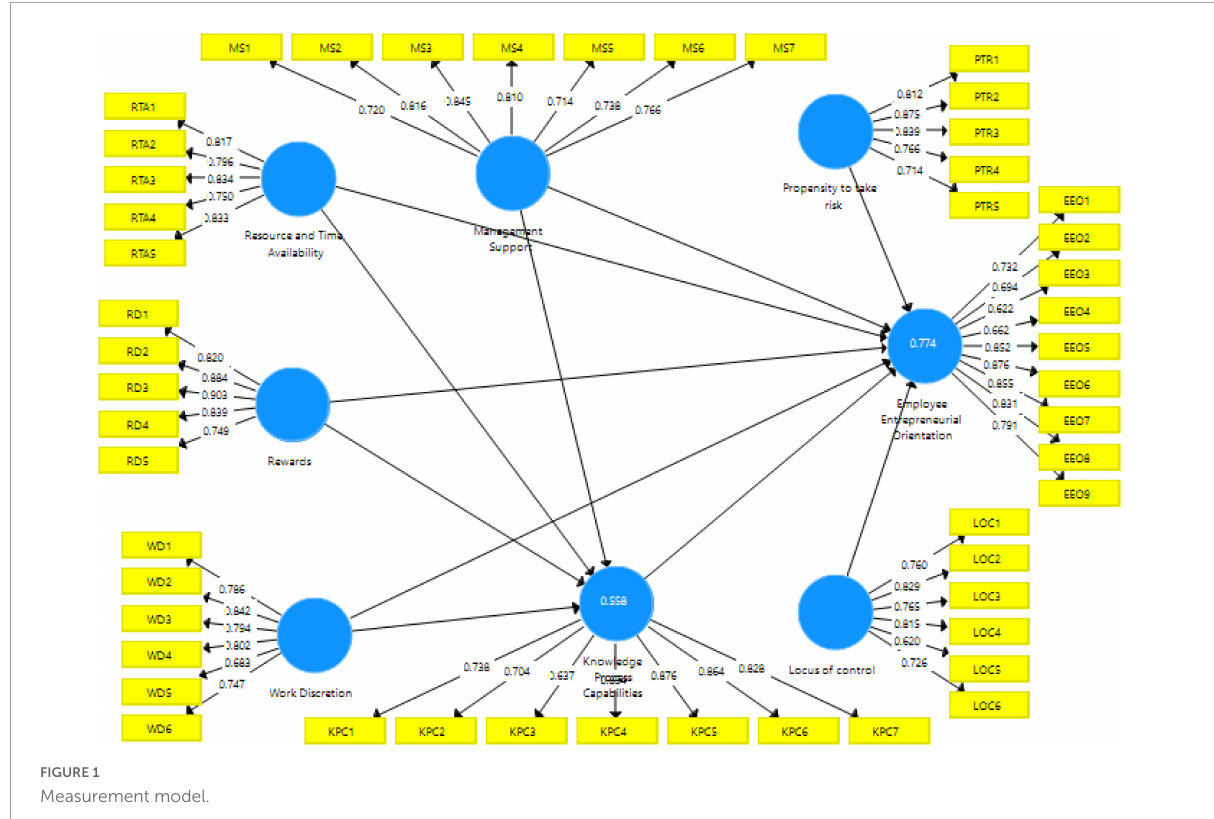
FIGURE1 Measurement